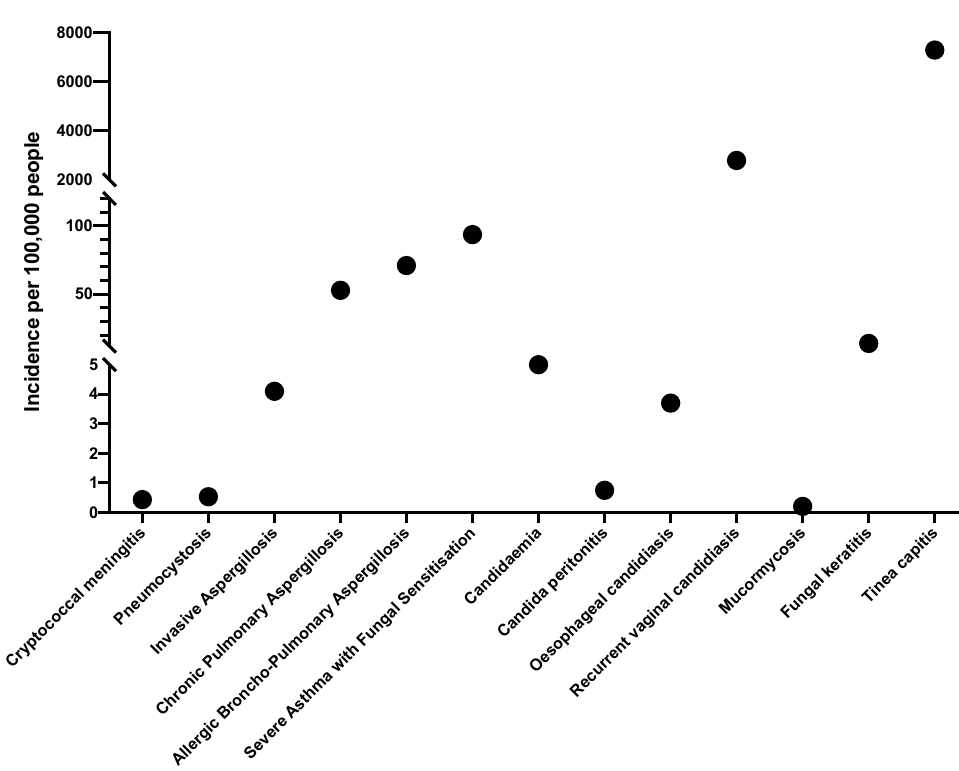
Figure 1. The estimated population annual incidence and prevalence of selected invasive fungal diseases in Morocco.